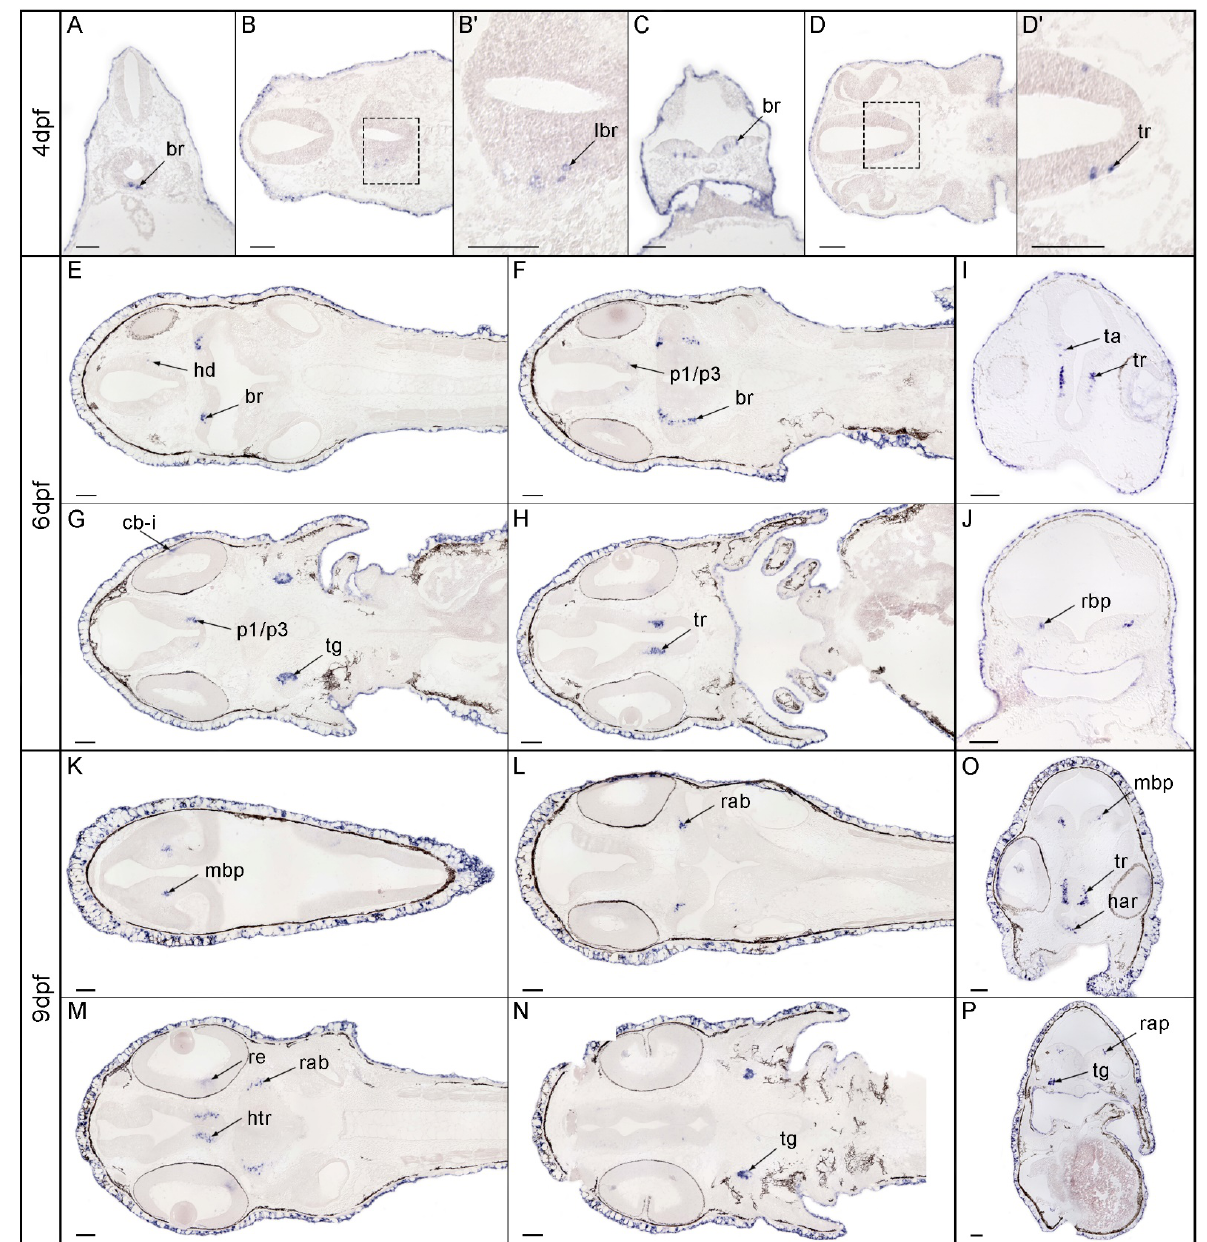
Figure 3. Expression patterns of nos1 in spotted gar embryos (4-6-9 dpf). At 4 dpf, nos1 -positive cells were localized in the rhombencephalon ( A – D ) in the 4th ventricle ( C ) and in the tuberal/retrotuberal region ( D , D’ ). At 6 dpf, nos1 expression localized in the rhombencephalon and the hypothalamic domain ( E , F , J ), the basal plate of the diencephalon proper p1-p3 ( F , G ), the trigeminal ganglia, in the primordium of the ciliary body/iris in the eye ( G ), ventrally in the tuberal/retrotuberal region ( H , I ), and the thalamic area ( I ). At 9 dpf, nos 1 expression was detectable in the basal plate of the mesencephalon ( K – O ), the rhombencephalon ( L , M , O ), the tuberal/retrotuberal region of the hypothalamus and retina ( M – O ), and the trigeminal ganglia ( N – P ). Abbreviations: br, basal rhombencephalon; cb, ciliary body; har, hypothalamic acroterminal region; hd, hypothalamic domain; i, iris; lbr, latero-basal rhombencephalon; mbp, mesencephalic basal plate; p1/p3, basal plate of prosomere 1 to 3; rab, rhombencephalic alar basal boundary; rbp, rhombencephalic basal plate; re, retina; ta, thalamic area; tr, tuberal region; tg, trigeminal ganglia. Scale bar: 100 µm .